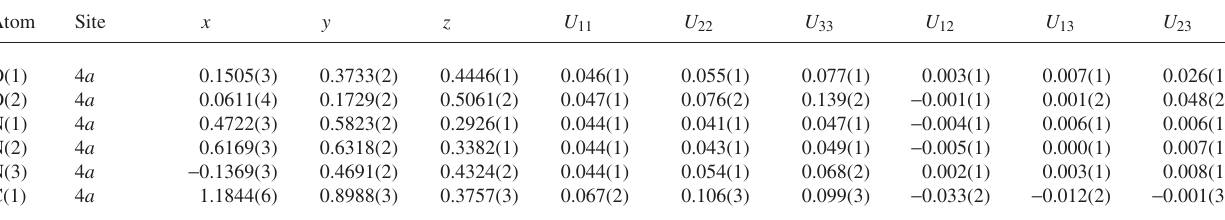
Table 3. Atomic coordinates and displacement parameters (in Å 2 )